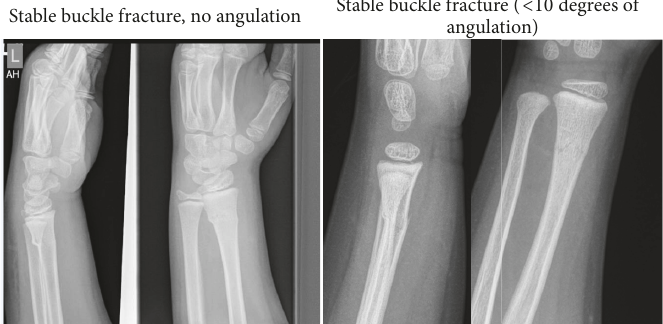
Figure 1: Angulated and nonangulated buckle fractures.